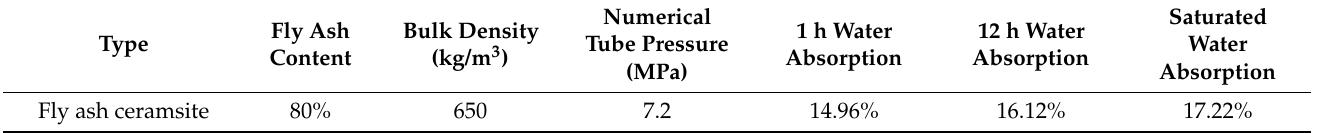
Table 1. Physical properties of ceramsite aggregate.